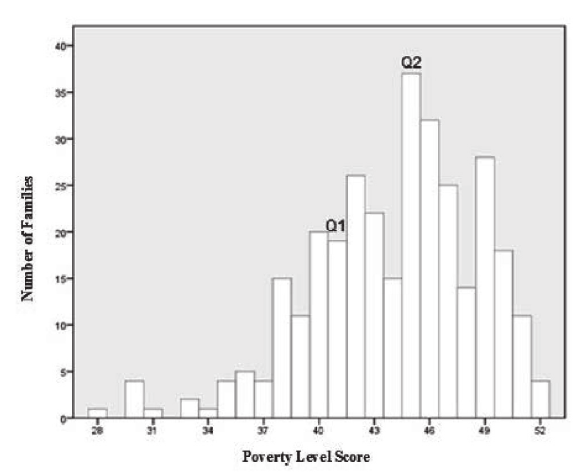
Figure 1 - Distribution of the Poverty Level Score of the Families, Belém -